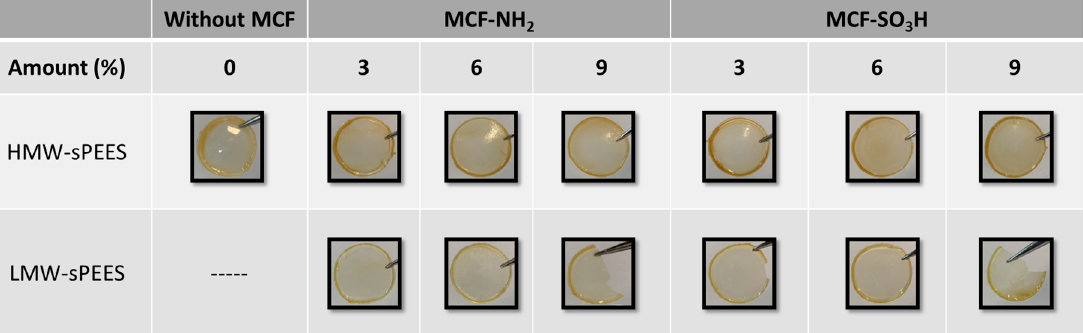
Figure 10. Images of composite membranes prepared from A. HMW-sPEES and B. LMW-sPEES with MCF modified with -NH 2 and -SO 3 H groups.